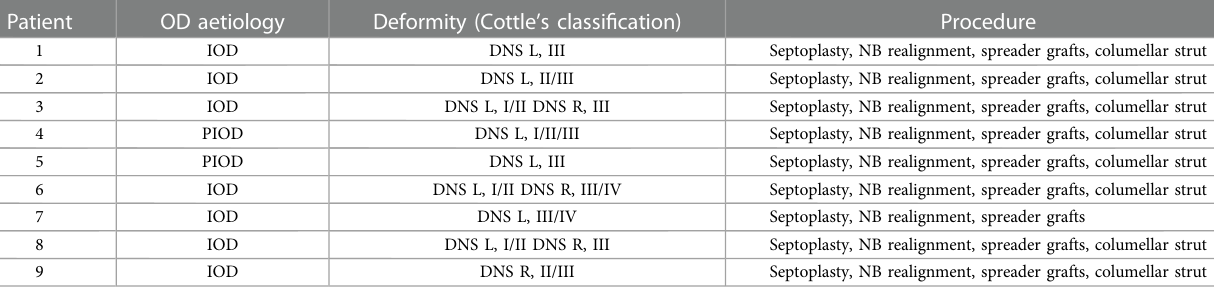
TABLE 1 Clinical deformity and surgical